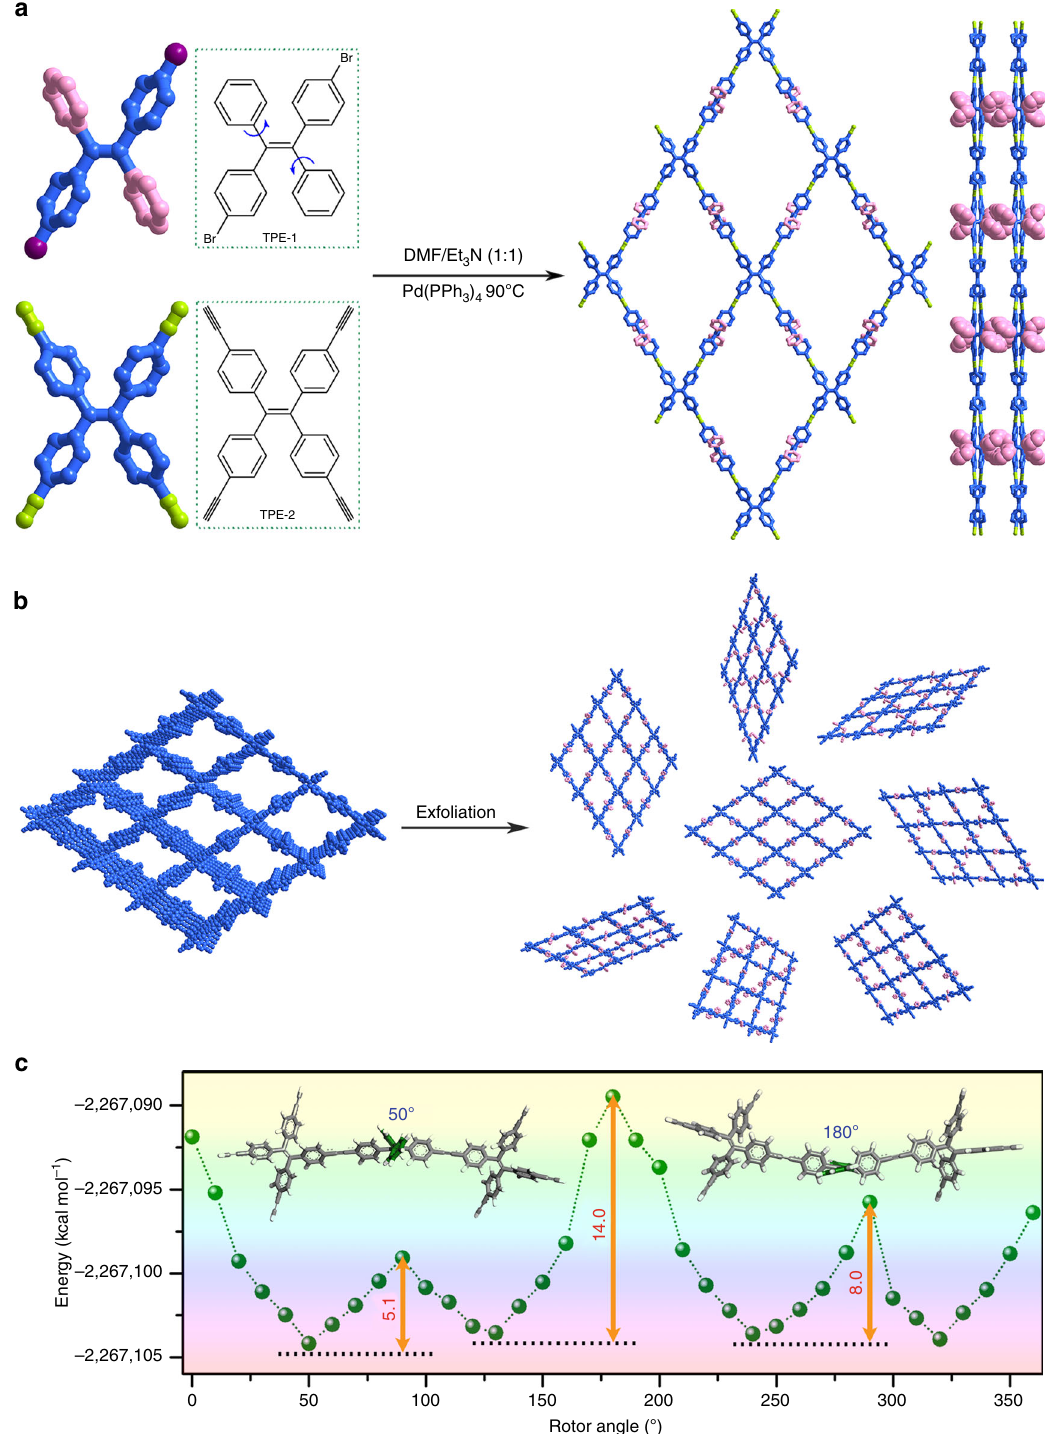
Fig. 1 Design and synthesis of NUS-24 nanosheets. a Synthetic route of NUS-24 bulk powder by Sonogashira – Hagihara coupling reactions. b The schematic diagram for the exfoliation of NUS-24 from bulk layered material to 2D nanosheets. The phenyl rings with pink color represent dynamic TPE rotors whose motion can be liberated after exfoliation. c Theoretical calculations of energy barrier of TPE rotors in the constructed